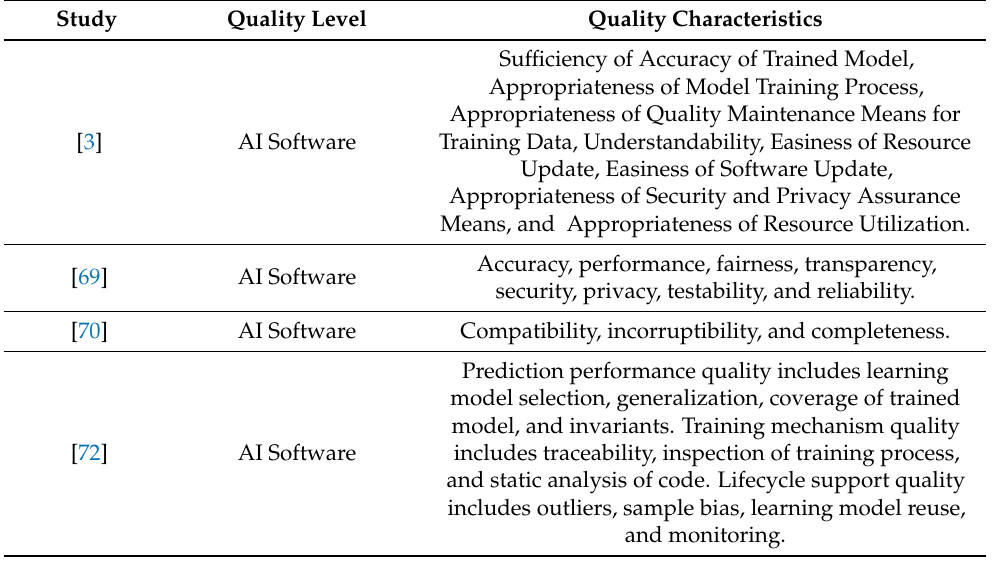
Table 6. Quality Characteristics for AI